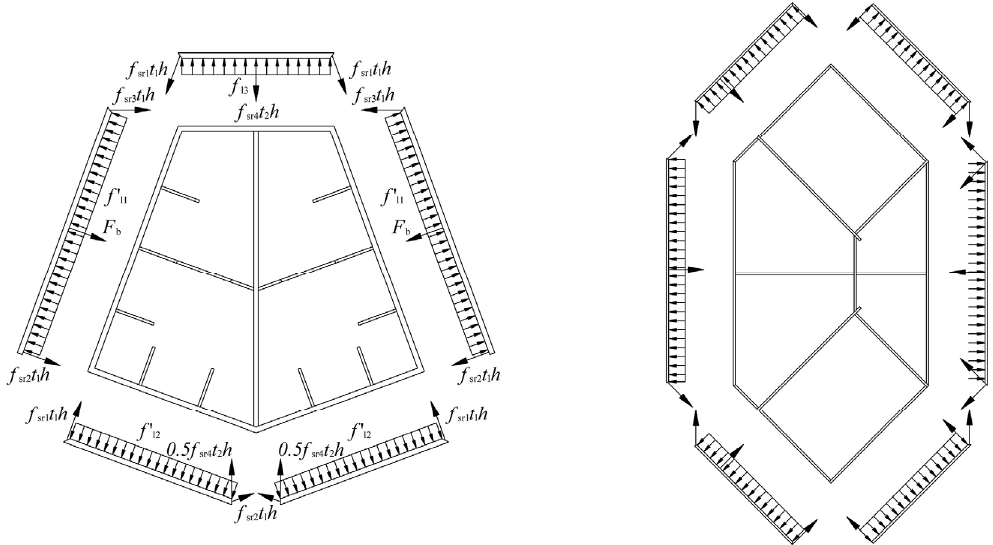
Figure 13. The diagrams of the isolated bodies of the specimens.